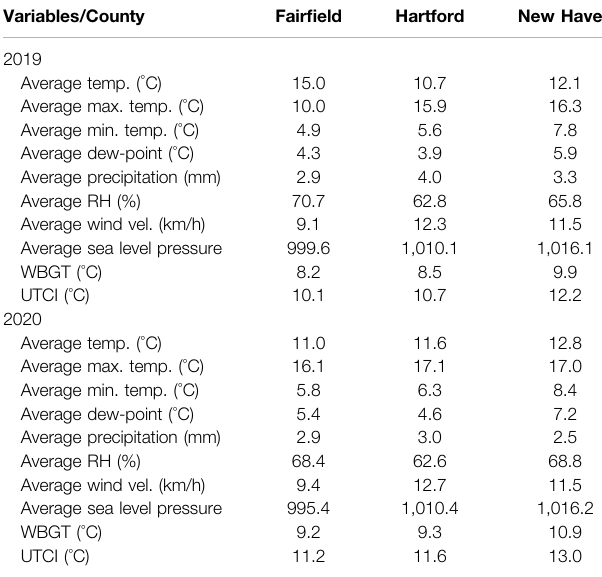
TABLE 3 | Summary of the averages of the environmental variables and thermal indices in the study